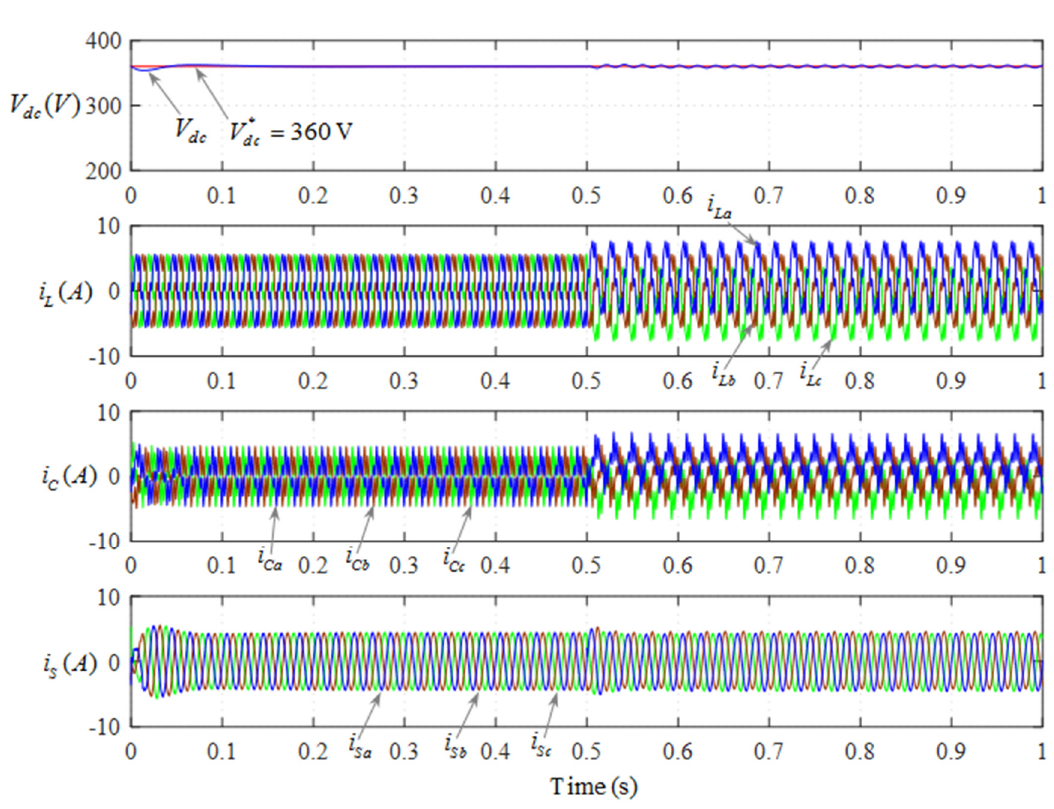
Figure 10. The DC bus voltage, the load current, the compensated current, and the source current using ADALINE method for Case 2.